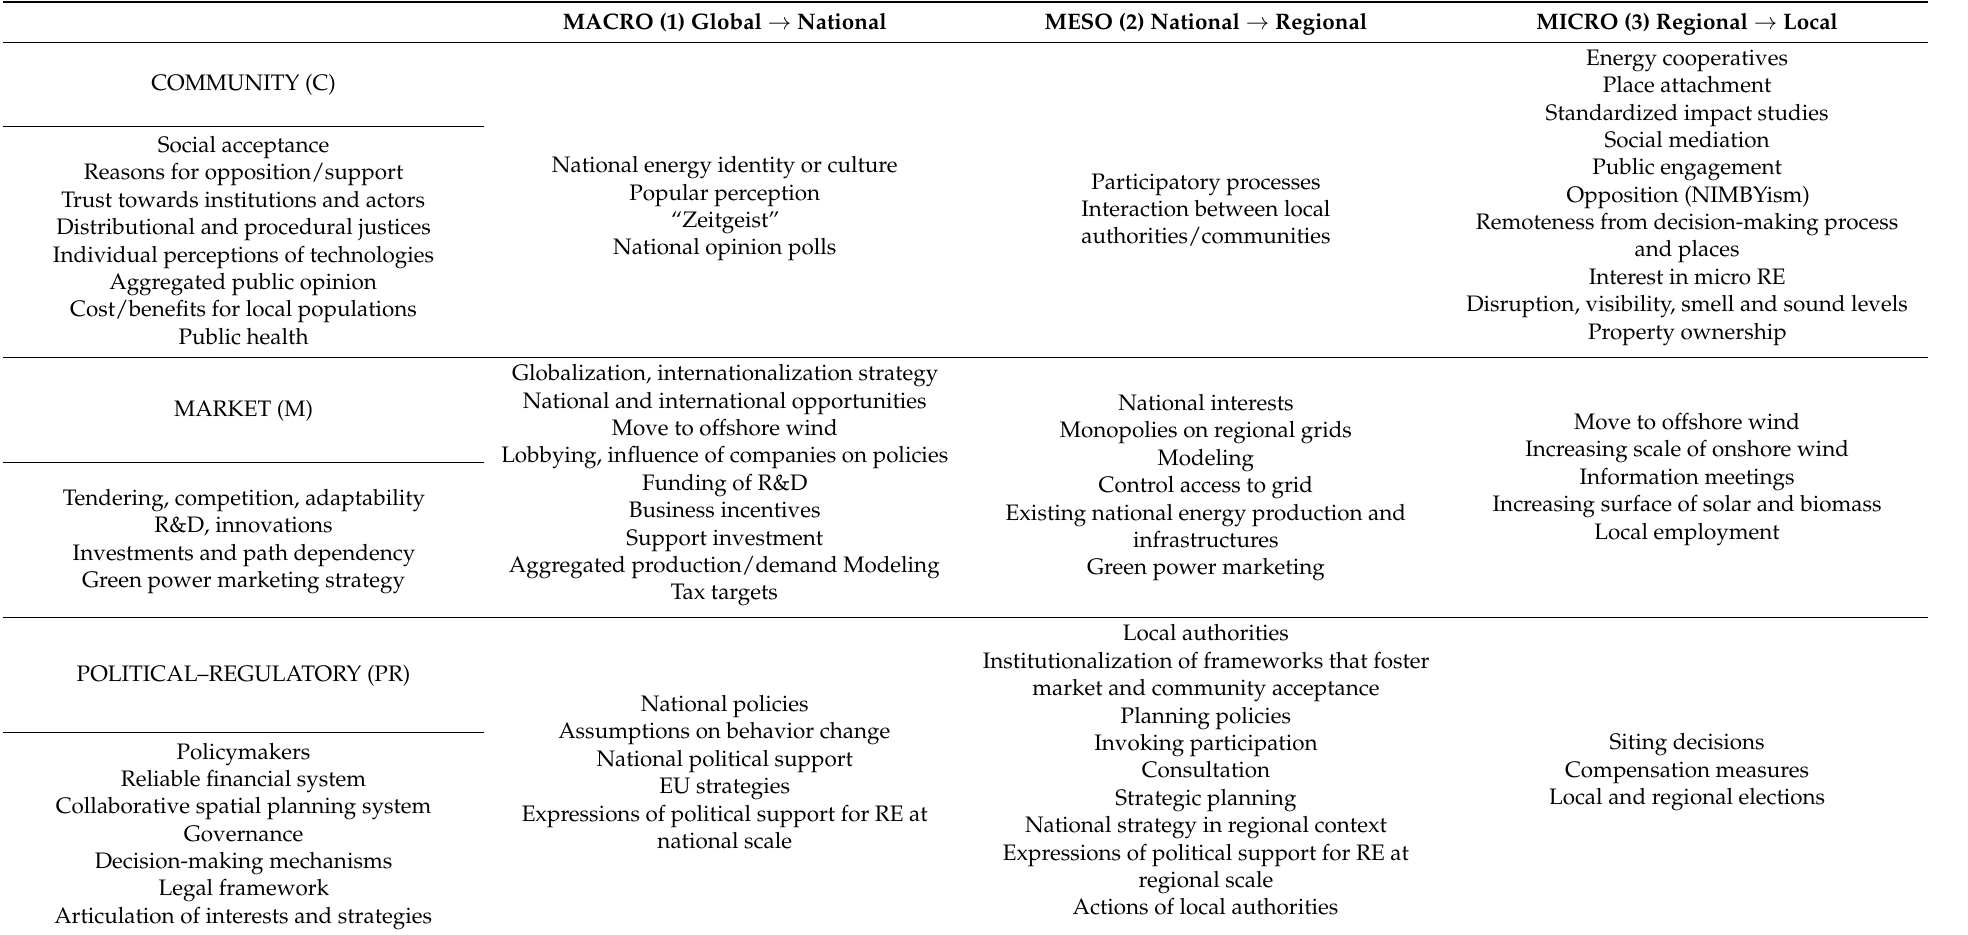
Table 2. Analytical framework by dimension and scale. This describes RE policy and development phenomena and processes that occur at different scales and dimensions. This list is illustrative rather than exhaustive and provides a characterization of each element within the